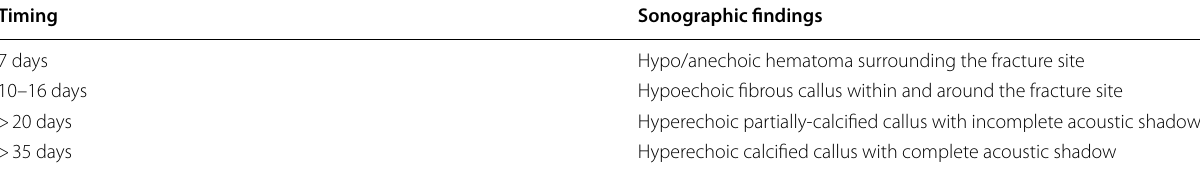
Table 2 Healing phases of bone